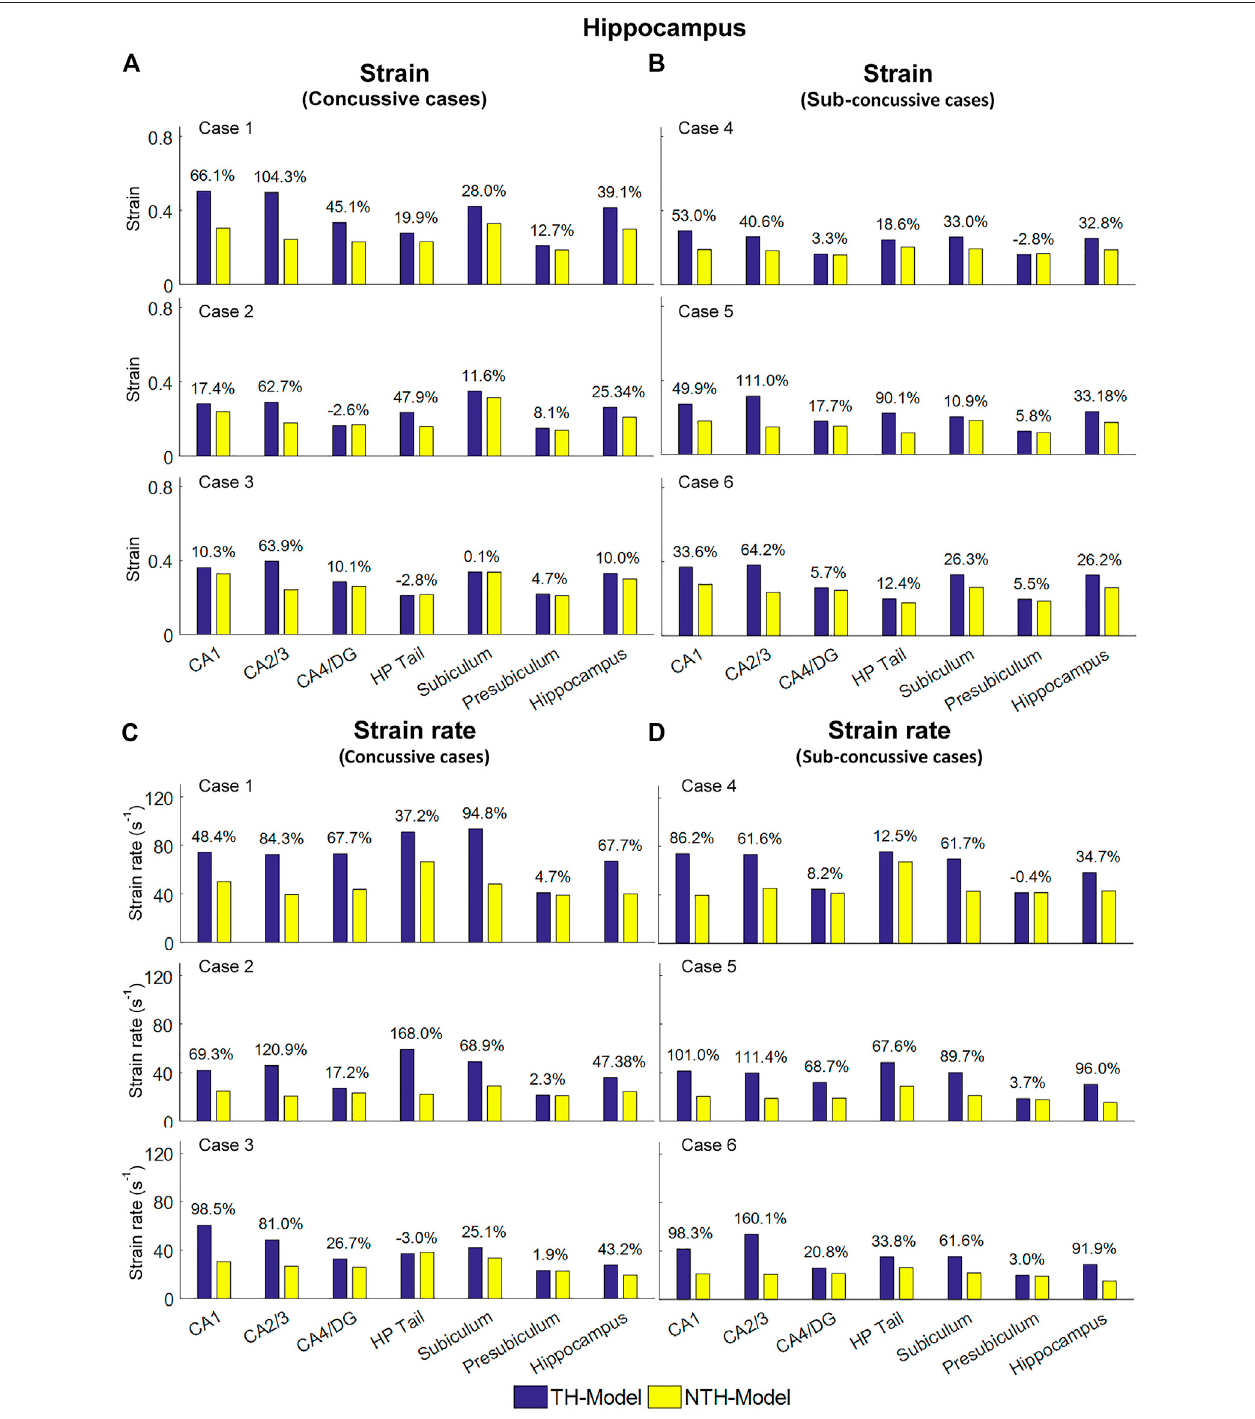
FIGURE5| Comparisonofthe95thpercentilemaximumprinciplestrainandstrainrateinthehippocampalsub fi eldsandthewholehippocampusbetweentheTH- Model and NTH-model of three concussive impacts (Cases 1 – 3) and three sub-concussive impacts (Cases 4 – 6). (A) Comparison of strain in the hippocampal sub fi elds of three concussive impacts. (B) Comparison of strain in the hippocampal sub fi elds of three sub-concussive impacts. (C) Comparison of strain rate in the hippocampal sub fi eldsofthreeconcussiveimpacts. (D) Comparisonofstrainrateinthehippocampalsub fi eldsofthreesub-concussiveimpacts.Percentagesinstraindifference and strain rate difference are calculated with the results of the NTH-Model as the baseline. CA: cornu ammonis; DG: dentate gyrus; HP Tail: hippocampal tail.